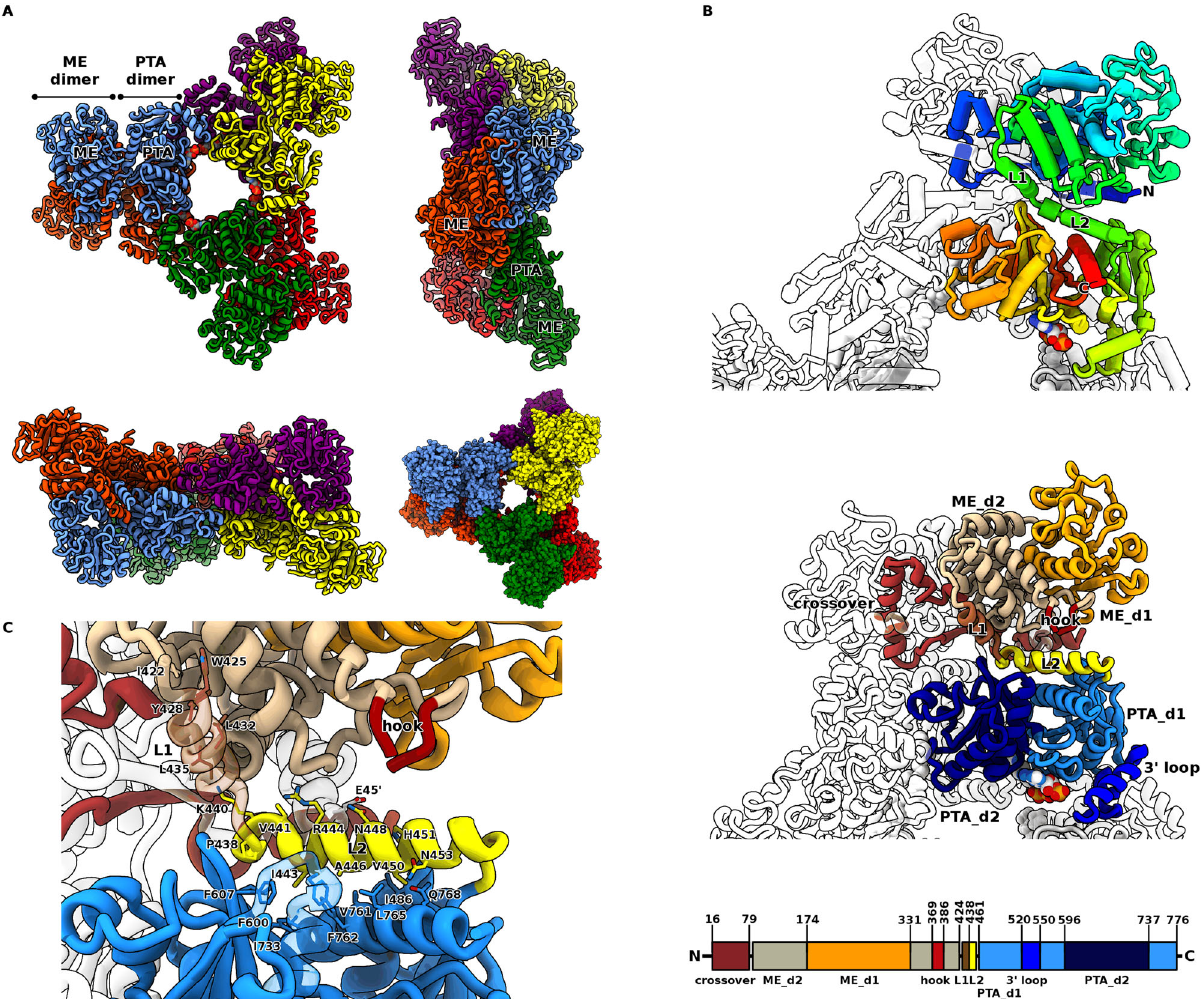
Fig. 5 Structure of the full-length hybrid MaeB acetyl-CoA complex. A The full-length ME:PTA MaeB protein retains the features of the isolated ME dimer and PTA hexamer, forming a central regulatory “ hub ” with the twofold axis of the enzymatic domains aligned with the PTA dimer axis. The hexamer is viewed from front, side and edge, with an additional front view in space fi ll form demonstrating a clear groove/channel between the PTA and ME domains. The ME dimer is offset from the PTA “ ring ” edge by ~40°, as observed in the angle between the ME dimer and vertical axis in the upper-righthand panel. B Architecture of the hybrid MaeB enzyme: top panel, Jones rainbow (colouring from blue N-terminus to red C-terminus); middle panel, subdomains labelled and coloured identically to the fi gures of the isolated structures; lower panel, schematic of sequence elements. The ME and PTA domains are linked by two α -helices, labelled L1 (brown) and L2 (yellow), associated with the ME and PTA domain, respectively. C Residue interactions at the L1-L2 linker region. Part of L1 is rendered transparent for clarity, showing that L1 packs with several hydrophobic residues against the ME fold. Helix L2 makes hydrophobic interactions at the N-terminus, and more polar contacts at the C-terminal end. The placement of L2 disorders the ME hook subdomain and makes a small contact to the ME crossover region (at residue